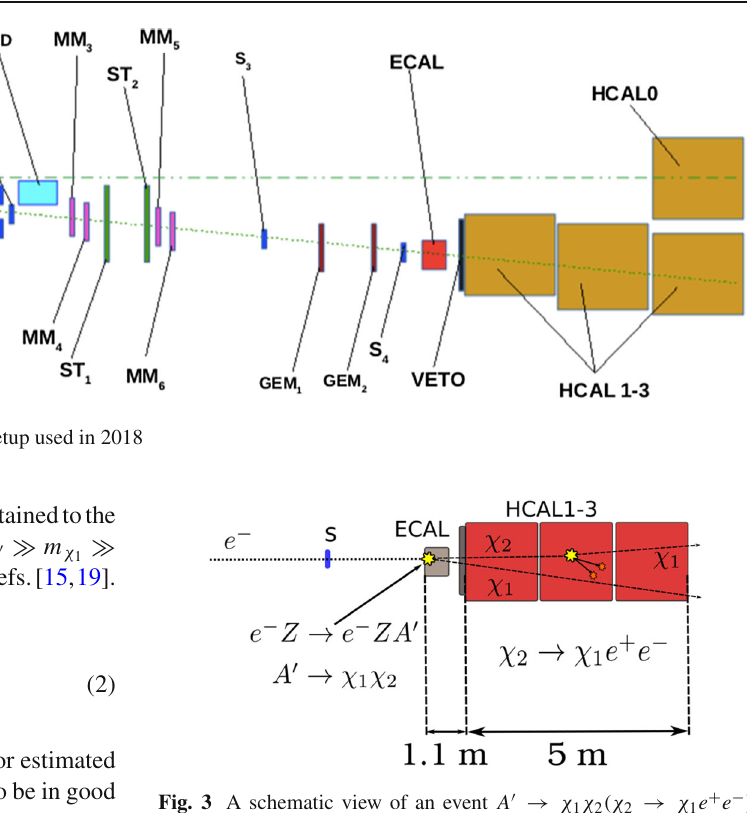
Fig.2. The experiment uses a set of scintillator and veto coun- ters, a magnet spectrometer consisting of two dipole mag- nets, and a set of tracking detectors (six micromegas